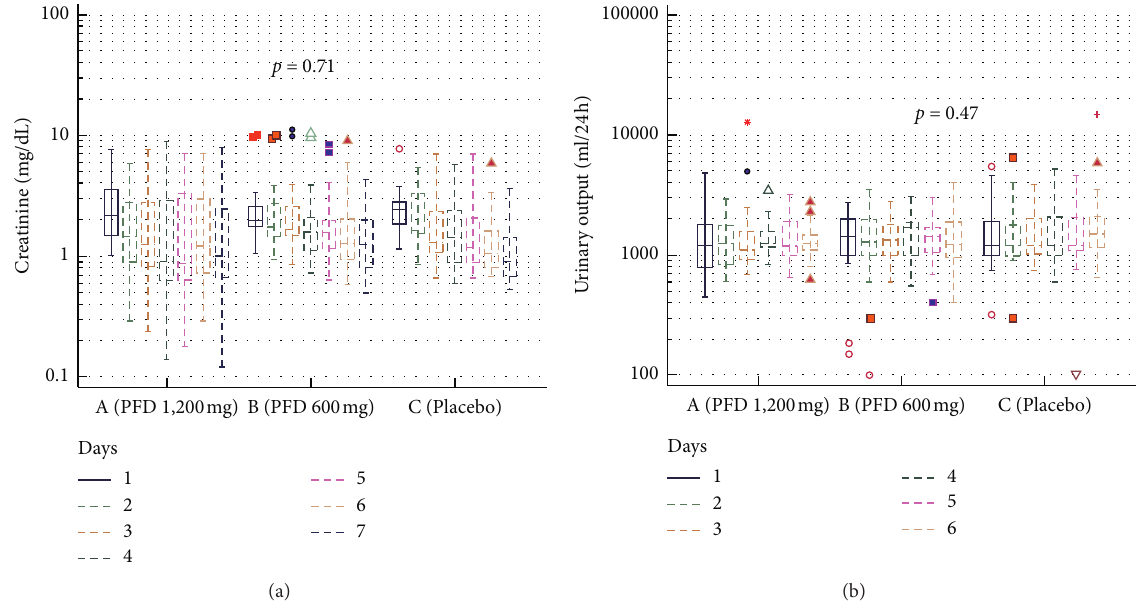
Figure 2: AKI trajectory during the intervention period by sCr (a) and UV (b) according to randomization